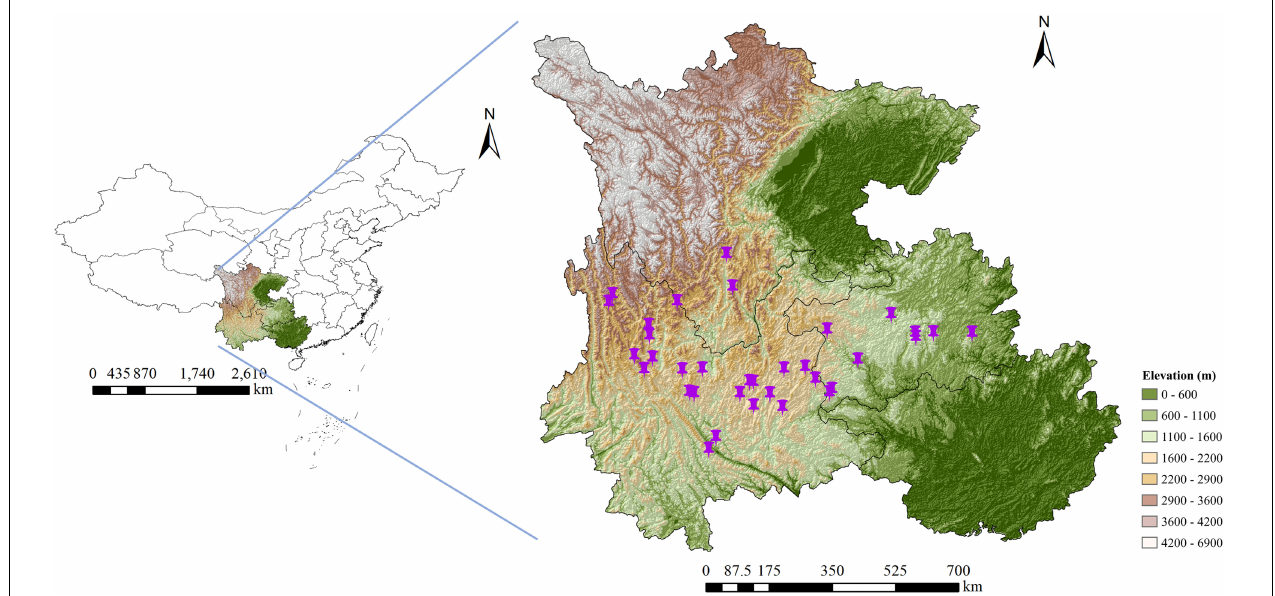
FIGURE 1 | The geographical location of wild G. rigescens